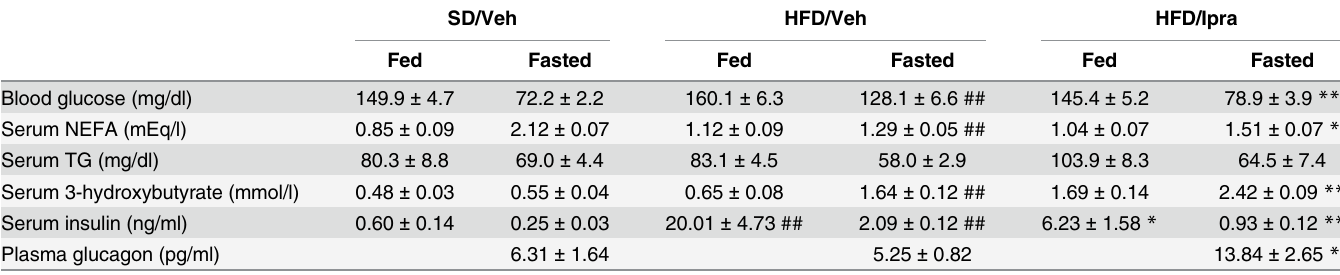
Table 1. Metabolic parameters of SD- or HFD-fed WT mice treated with or without ipragliflozin for 4